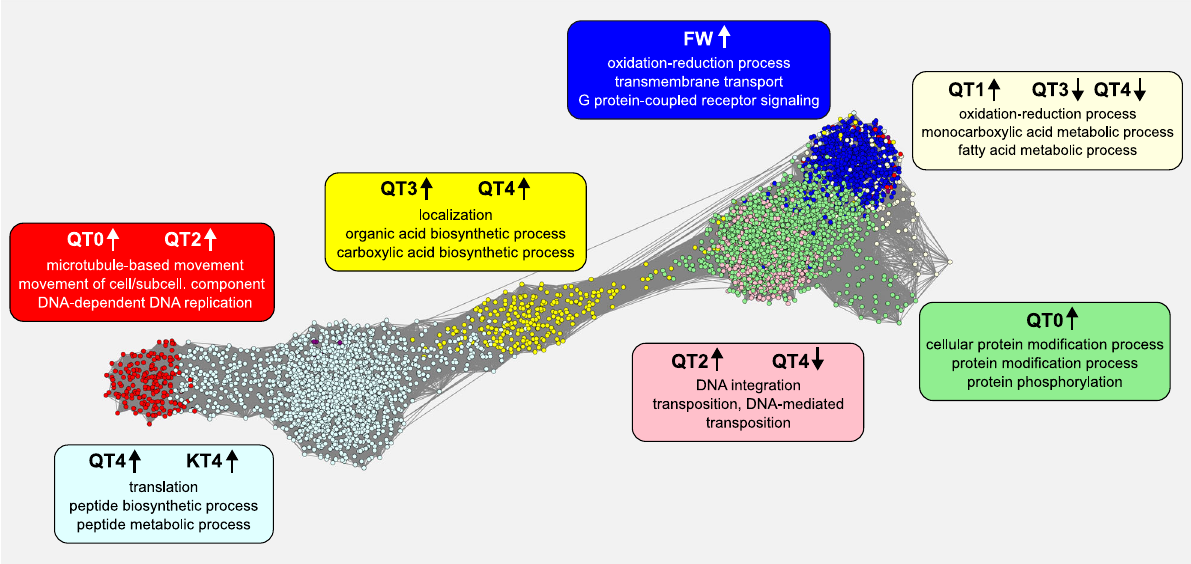
Fig. 2 Weighted gene co-expression network analysis (WGCNA). The gene co-expression network is displayed with genes as nodes and edges representing the co-expression relationships between genes. Nine modules were detected within which gene expression was especially strongly correlated (see Supplementary Fig. 2 for more details.) Shown are the seven largest modules, represented by colors. For each module, information is supplied on the caste or queen stage with which module expression is signi fi cantly correlated; upward arrow indicates a signi fi cant increase, downward arrow a signi fi cant decrease, in expression. The top three enriched GO terms associated with the gene members of each module are displayed (for full lists of signi fi cant GO terms, see Supplementary Data 1). This network was created with Cytoscape (version 3.8.0; Shannon et al. 77 ) on a reduced representation of the WGCN containing the top connected genes (see “ Methods ” for more